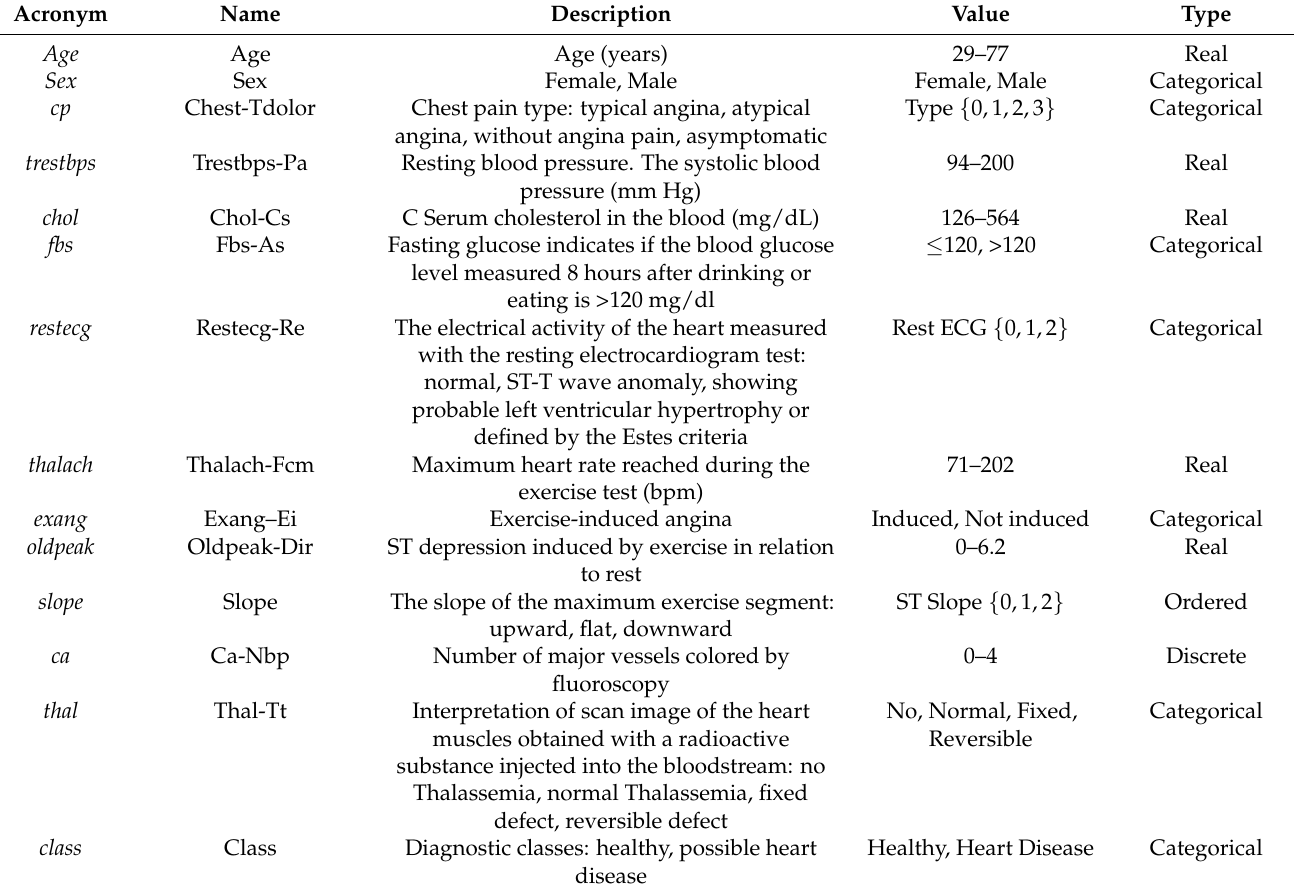
Table 1. Features of the Heart Disease data set